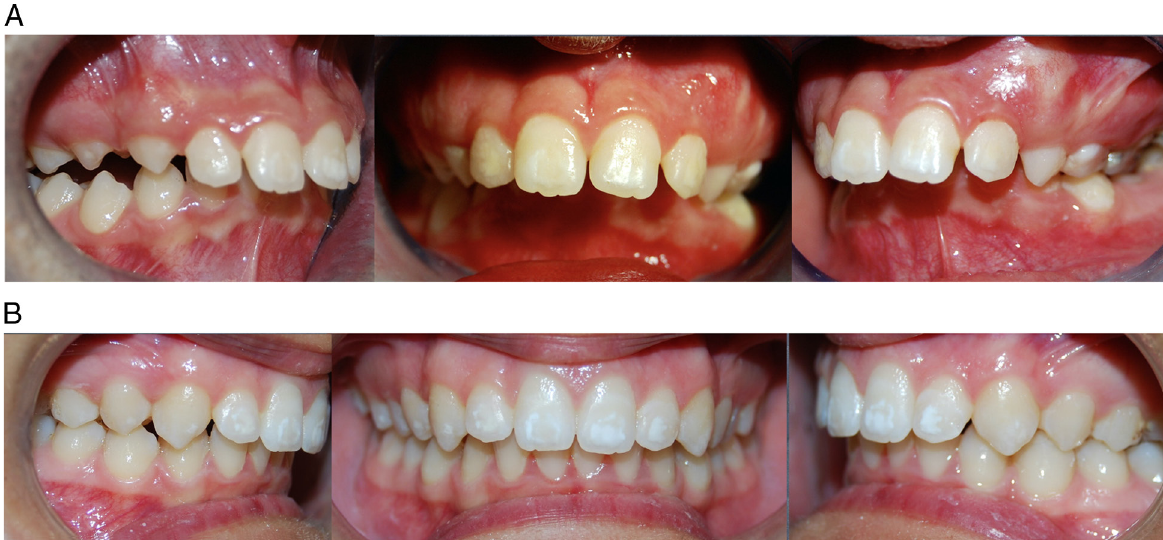
Figure 2. (A) Pre-treatment intra-oral photographs; (B) post-treatment intra-oral photographs.